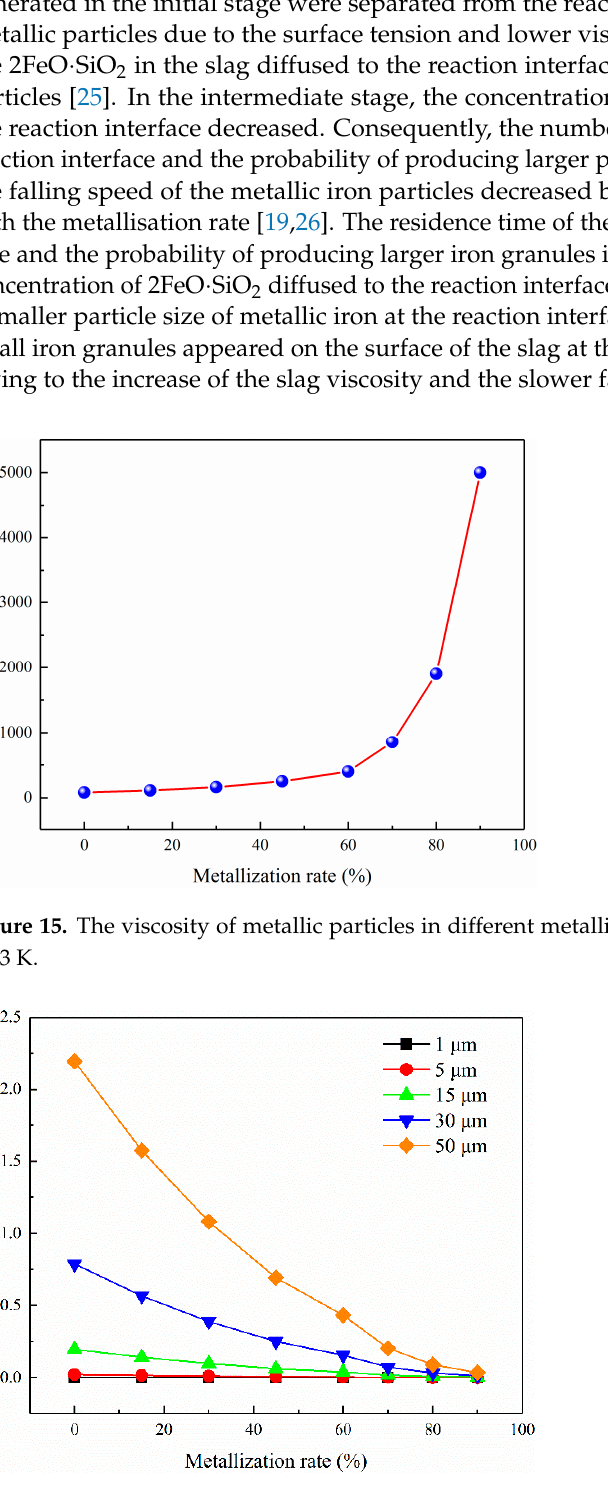
Figure 16. The average falling speed of metal particles in different metallisation rates at the temper- ature of 1573 K.